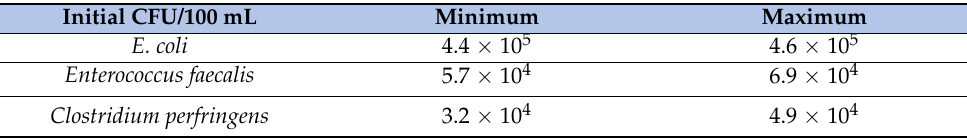
Table 4. The initial concentration of the bacteria in the water.